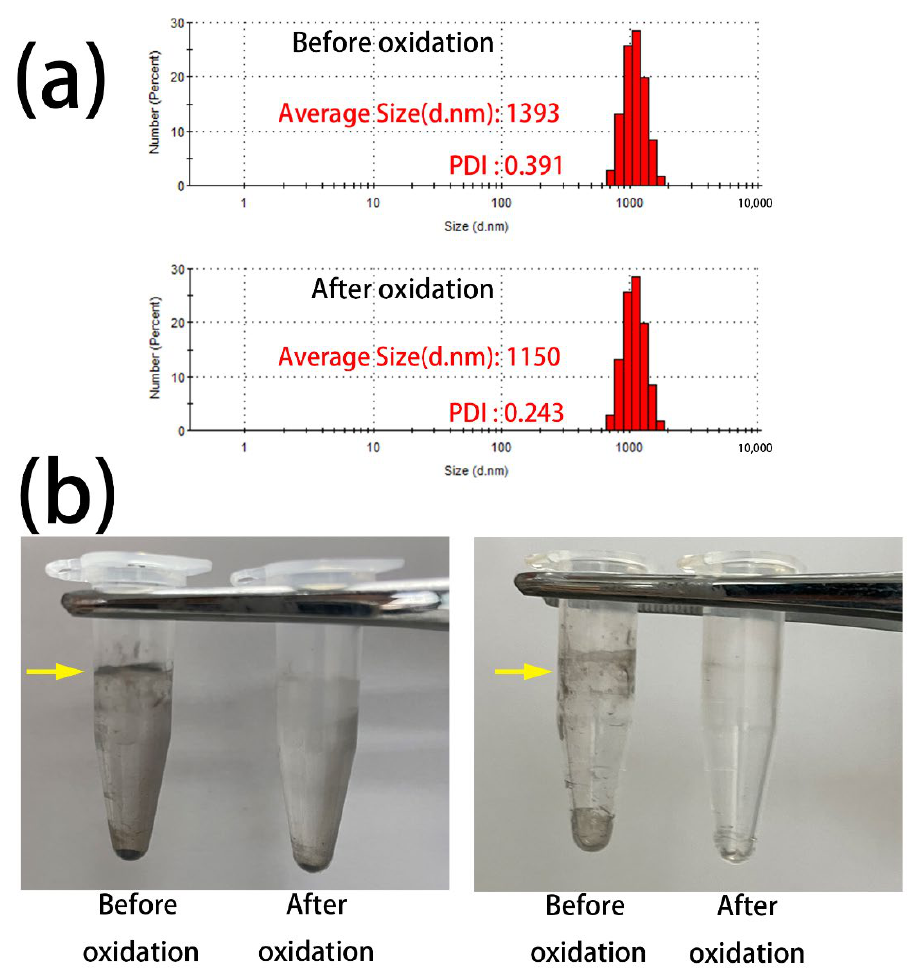
Figure 2. Oxidation effect comparison chart: ( a ) Histogram of diameter size distribution of GO@FeN-MB and G@FeN-MB; ( b ) Photos of GO@FeN-MB and G@FeN-MB.